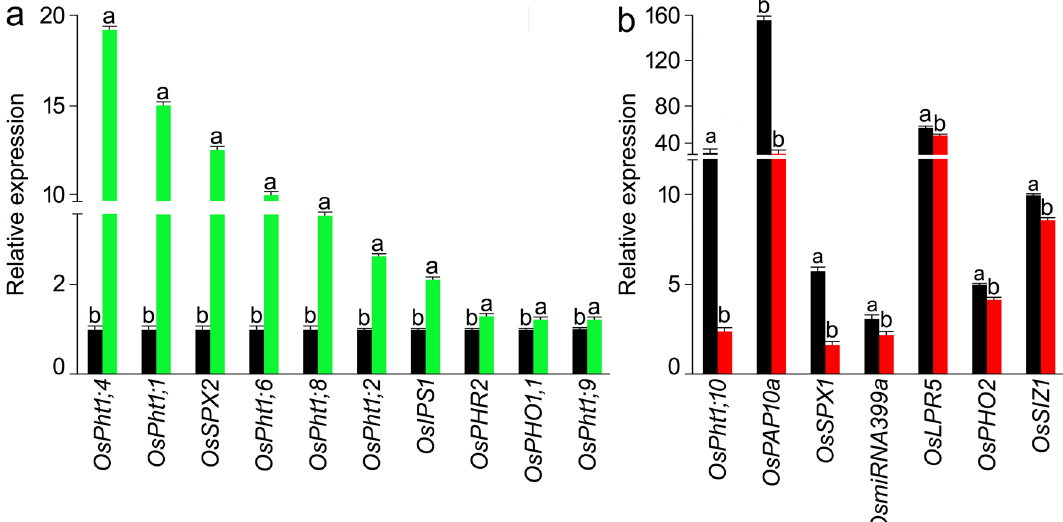
Figure 9. Relative expression levels of GPH in Pi-deprived roots of N22 and NH787 . N22 and NH787 were grown in potting soil under P+ and P− conditions up to 50% flowering stage and their roots were harvested. Quantitative real-time RT-PCR (qRT-PCR) was employed for determining the relative expression levels of GPH genes. ( a ) GPH genes induced in NH787 (green bars) compared with N22 (black bars). ( b ) GPH genes were suppressed in NH787 (red bars) compared with N22 (black bars). OsActin (LOC_Os03g50885) was used as an internal control. Values are means ± SE ( n = 6) and different letters on the histograms indicate that the values differ significantly ( P <